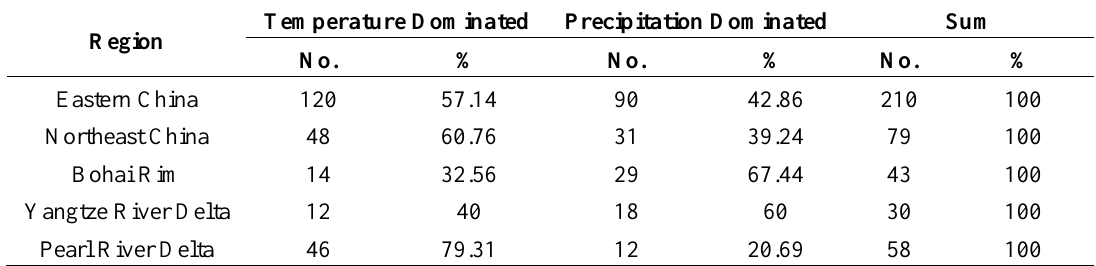
Figure 7. The primary climatic driving factors of vegetation change of meteorological stations in Eastern China.